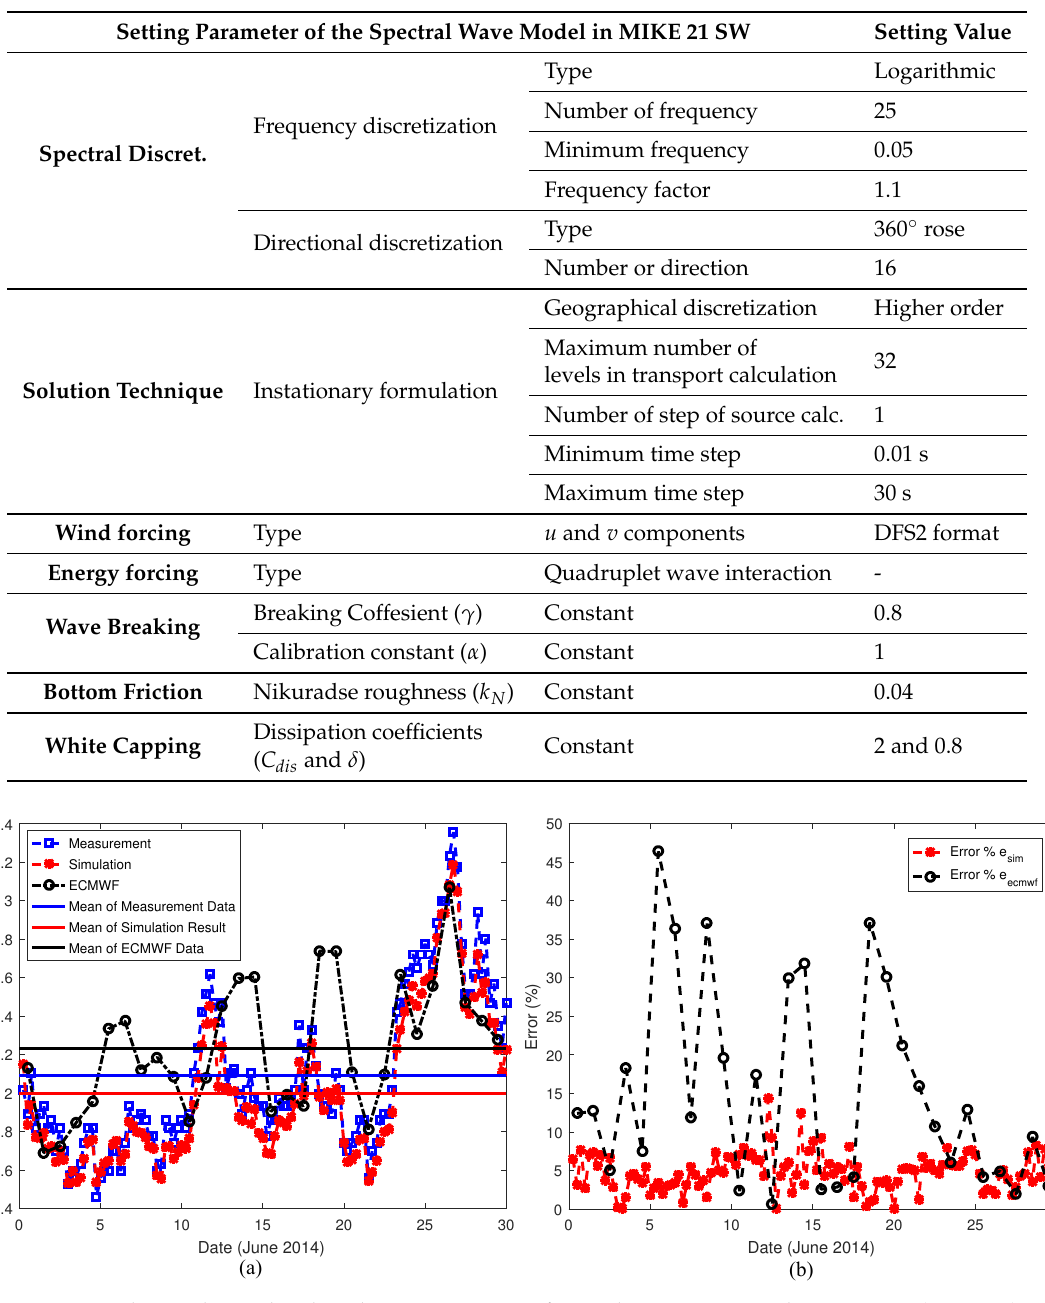
Table 1. Setting parameters of the spectral wave model in MIKE 21 SW.